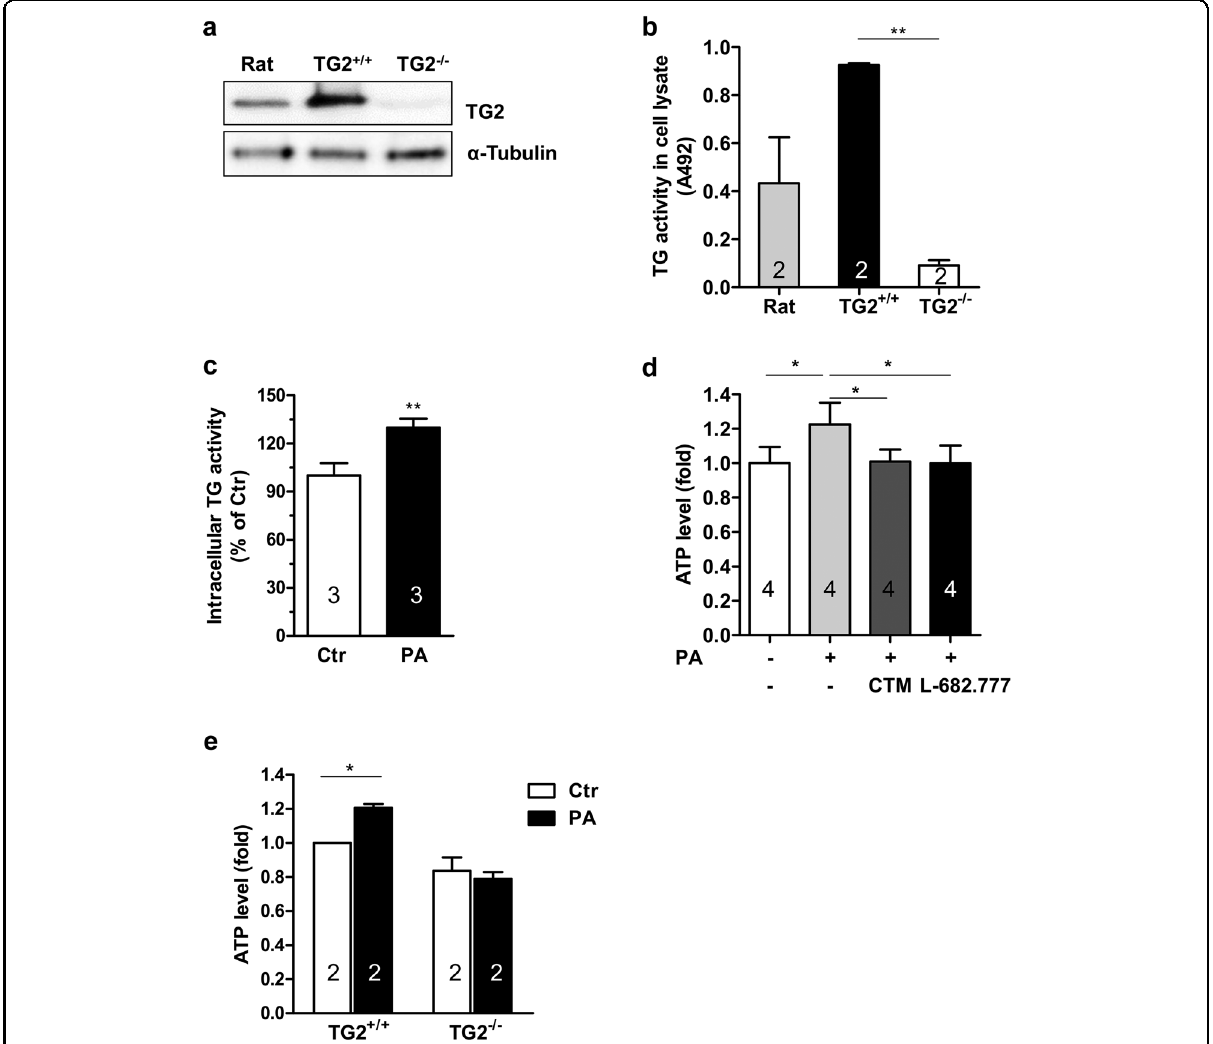
Fig. 1 Palmitic acid supplementation activates TG2 in murine cardiomyocytes. a , b TG2 protein level ( a ) and TG2 activity ( b ) were assessed in lysates of left ventricular (LV) myocytes isolated from rat, wild-type, and TG2-de fi cient mice. c Effects of palmitic acid supplementation (PA, 100 μ M) on intracellular TG2 activity. d ATP levels in PA-treated LV myocytes from rat hearts in the absence or presence of cystamine (CTM, 0.5 mM) or L-682.777 (100 μ M), inhibitors of TG2. e ATP levels in PA-treated LV myocytes from wild-type and TG2-de fi cent mice. Data represent mean ± S.D. * P < 0.05, ** P < 0.01 compared with